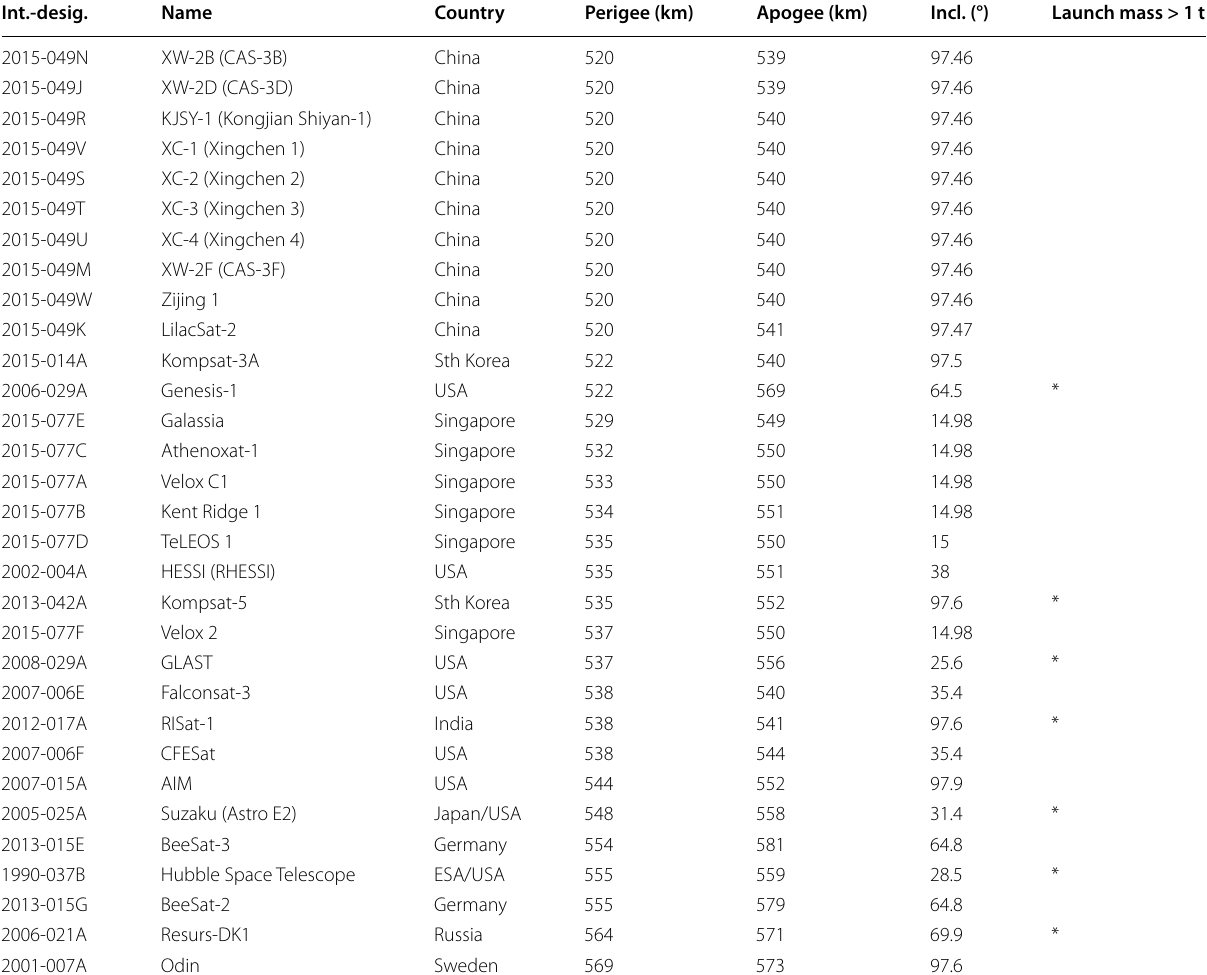
Table 5 List of active spacecraft within 520–580 km orbital altitude (UCS 2016)